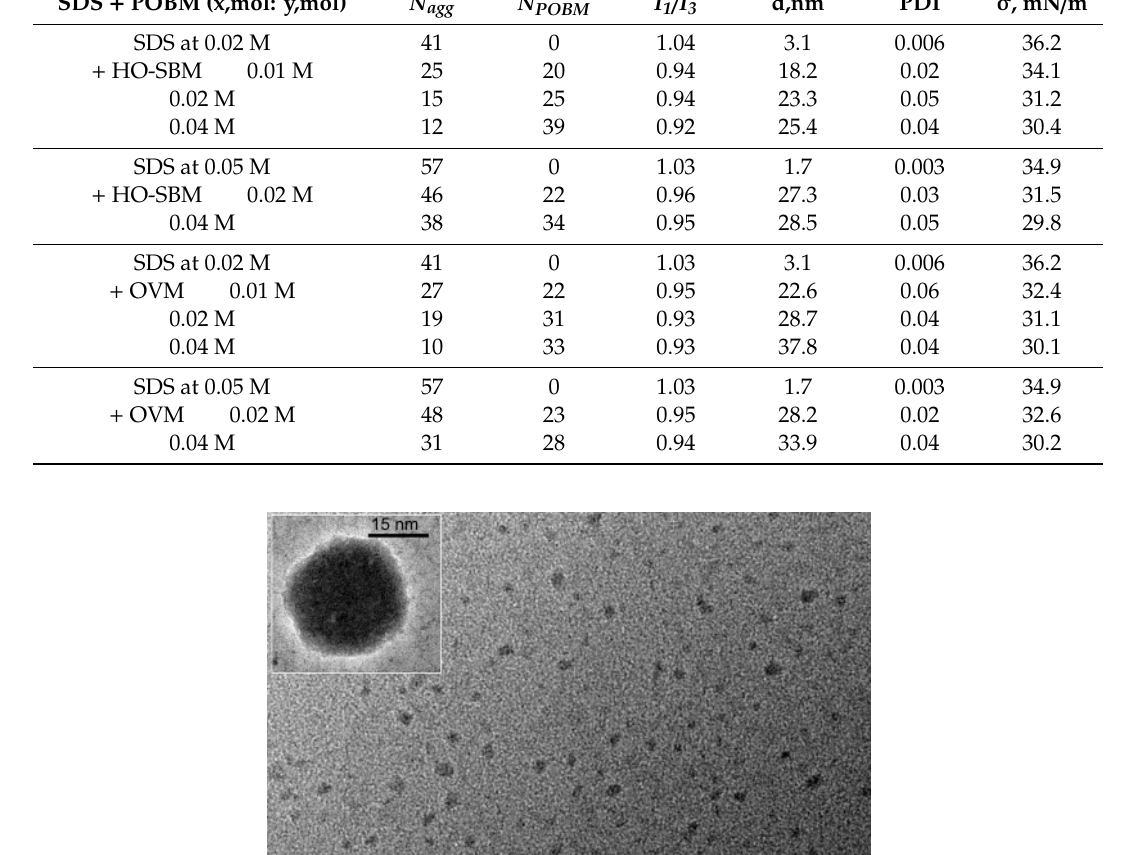
Table 3. Micellar parameters for SDS and POBM at different concentrations.